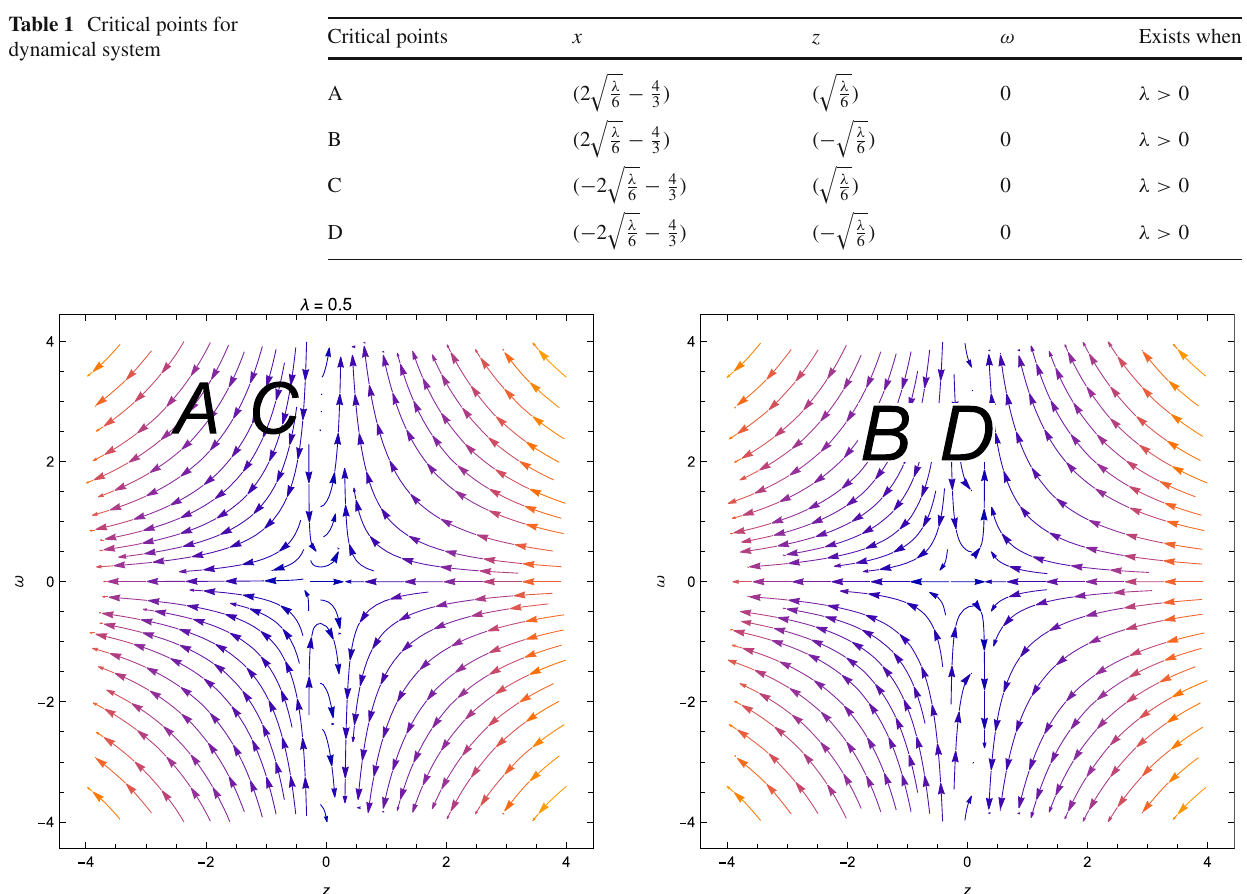
Fig. 1 Phase portrait for Power Law Model. Here we plot the graph between z and w . In the plot arrows represent the direction of the velocity fluid and the trajectories for this model Table 2 Stability conditions, deceleration parameter, density parameters Critical